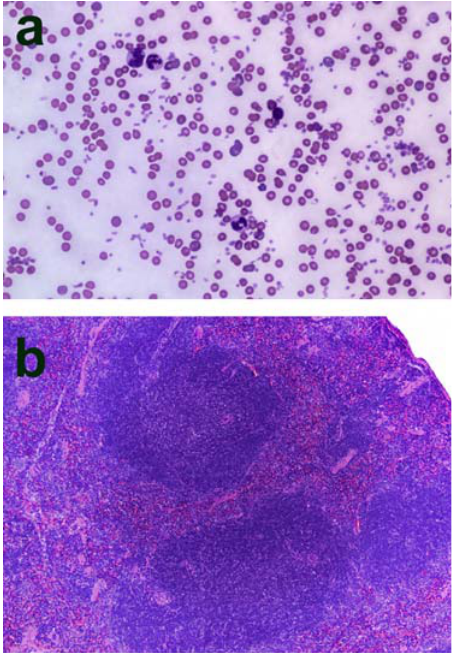
Figure 1. Confirmation of hematologic reconstitution of mice that were lethally irradiated and then transplanted with donor bone marrow cells; magnification, 6 100. a: Wright-Giemsa stained peripheral blood smear from a C3KO animal 14 weeks after bone marrow transplant from a WT mouse. Note presence of all three cell lines (erythrocytes, leukocytes, platelets). b: Hematoxylin and eosin stained spleen section from a C3KO mouse 14 weeks after transplan- tation from a WT animal. Note normal appearing lymphatic nodules. doi:10.1371/journal.pone.0003334.g001 (0.67%) of that found in WT animals. C3KO animals and C3KO IR /C3KO chimeras had C3 concentrations below 0.001 mg/ml, approaching the lower limit of the assay.